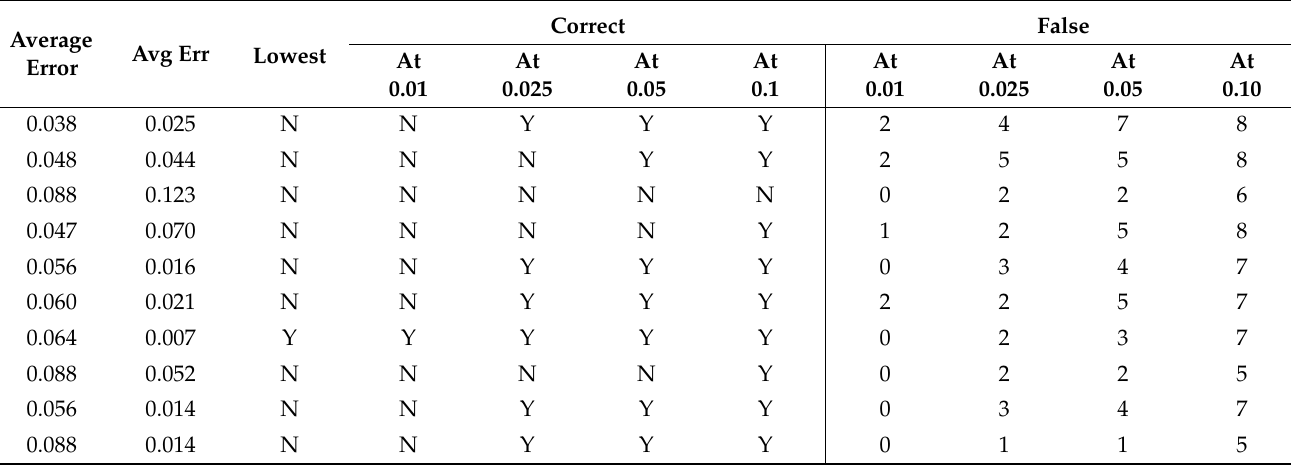
Table A155. Set 2, trials 41–50 summary data (all 0.5 PR